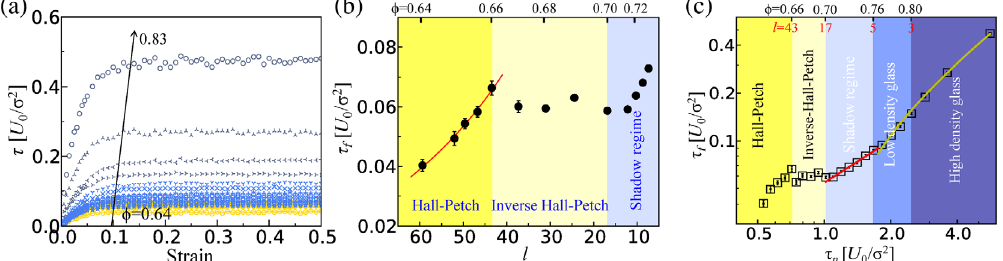
l Þ shows f ð l Þ follows the standard Hall- f ð τ shows the Mohr-Coulomb glassy behaviors with f ð n Þ